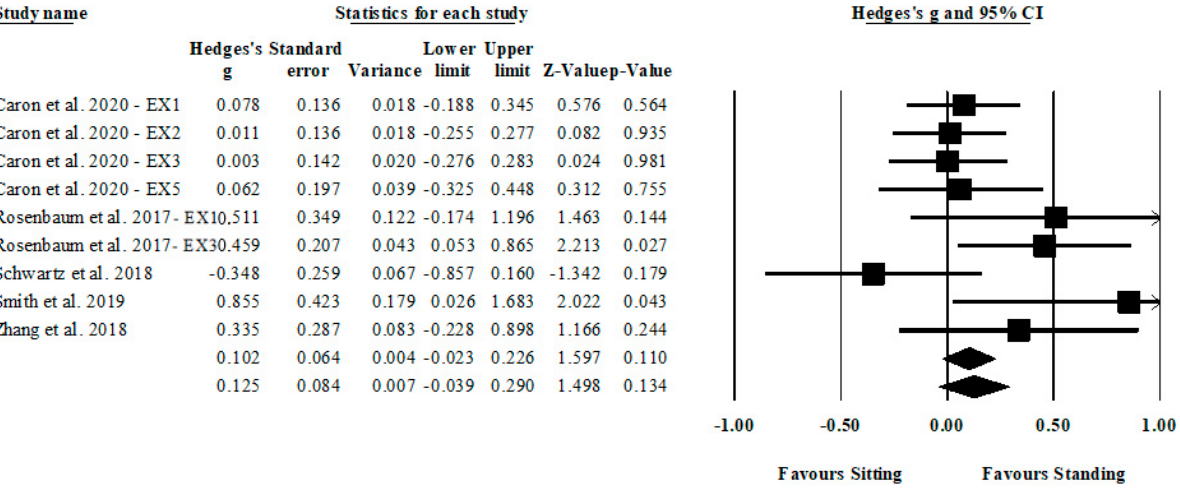
Figure 2. Forest plot of the Hedges’ g differences between sitting and standing conditions for the Stroop effect.